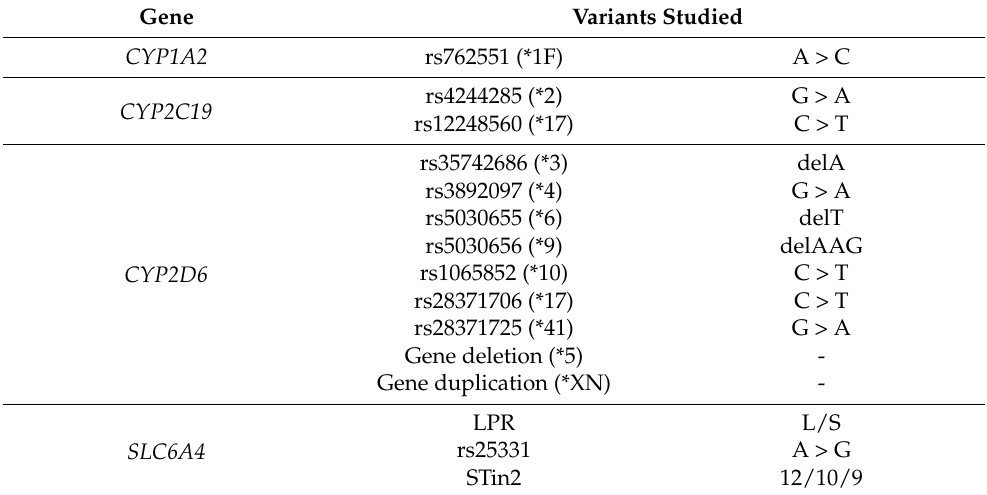
Table 2. Key pharmacogenetic variants